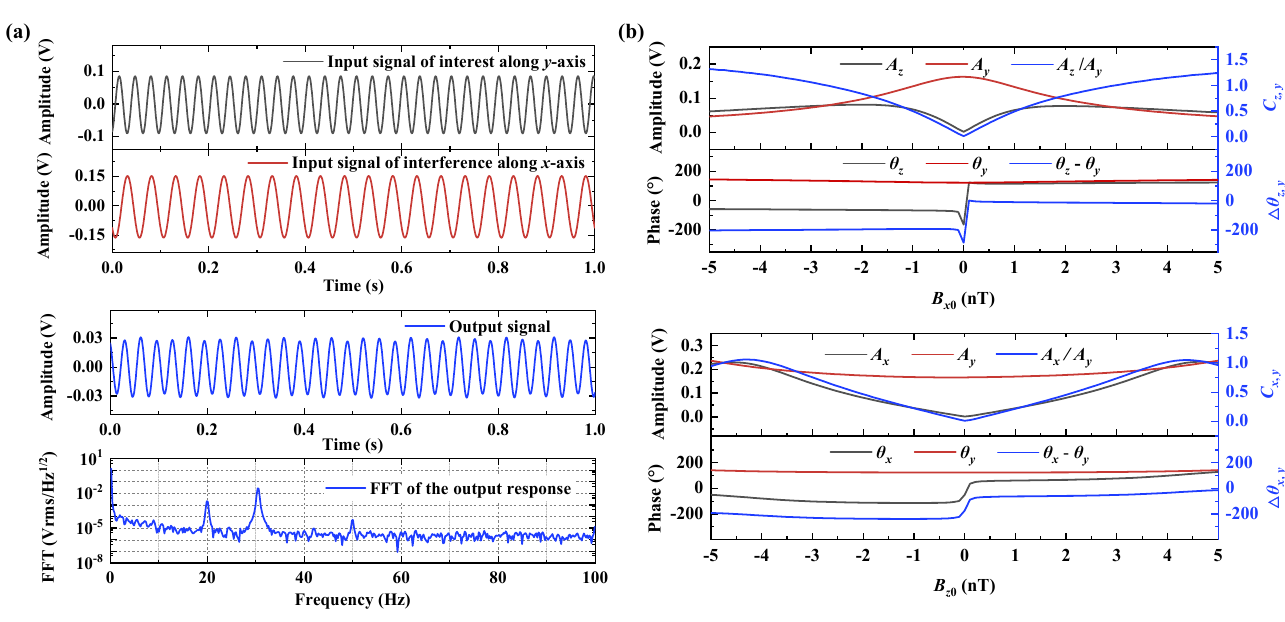
Figure 3. The output signal dependence on the background magnetic field. ( a ) Input signal in time-domain and the output signal in time-domain and frequency-domain. ( b ) Output response amplitude, cross-axis coupling coefficient, phase, and the phase difference for the sensitive and interference fields under the background magnetic field.